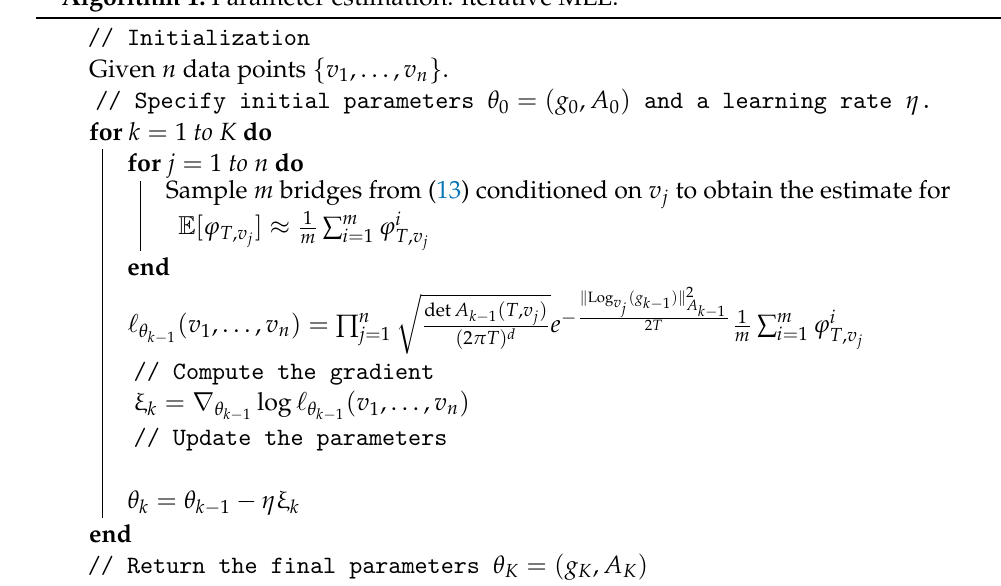
Algorithm 1: Parameter estimation: iterative